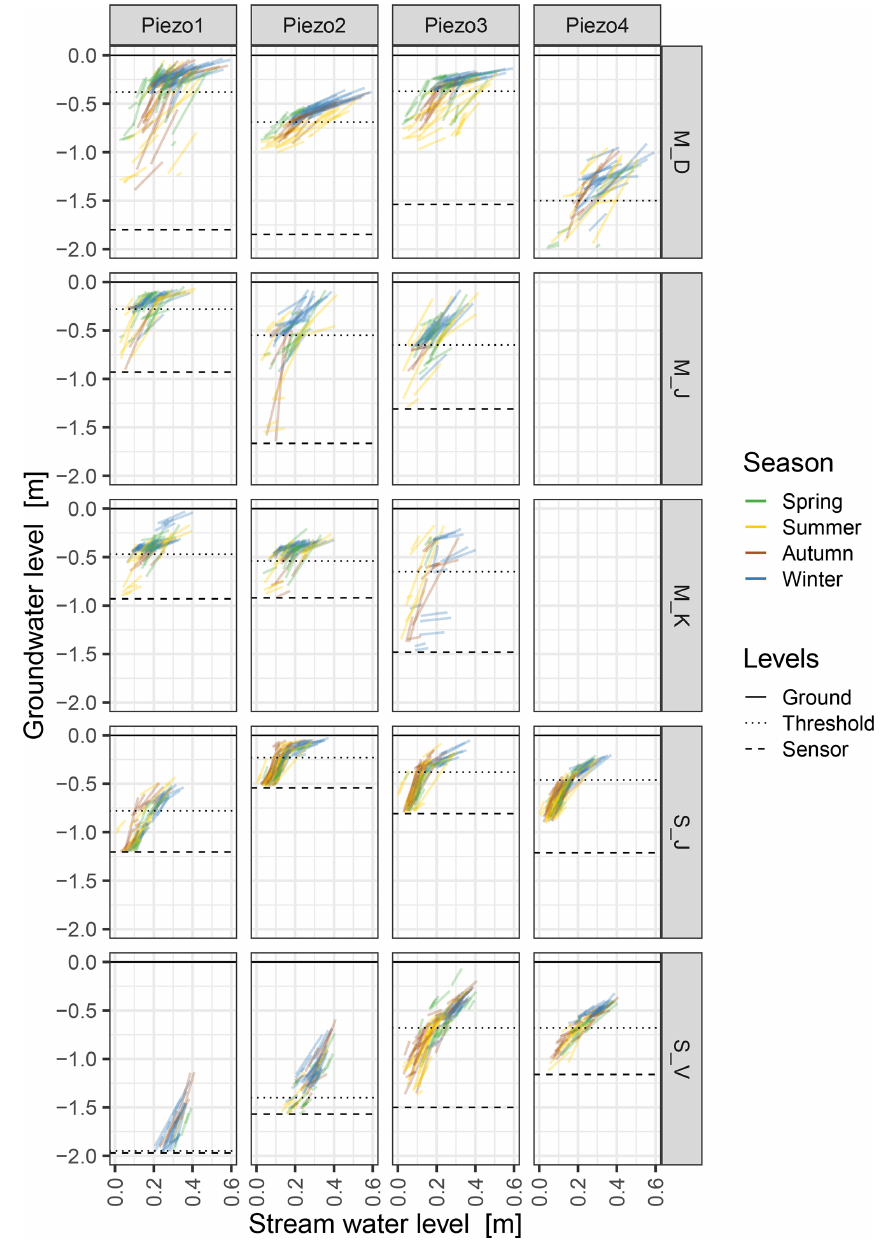
Figure 10. Responses in water tables of groundwater ( y axis) and the corresponding stream ( x axis). The lines connect the pre-event minimum with the event maximum. Note that these water levels do not necessarily occur at the same point in time as this visualisation removes the temporal dimension. The y axis of the plot ends at a depth of 2m for the purpose of comparison and thus omitting two events occurring below this groundwater level at M_D_Piezo4. Dotted horizontal lines illustrate the threshold between the lower (more variable but mainly steep sloping lines) and upper (less variable with shallow slopes) hydrologic response behaviour. The solid line indicates the ground surface and the dashed line the installation depth of the